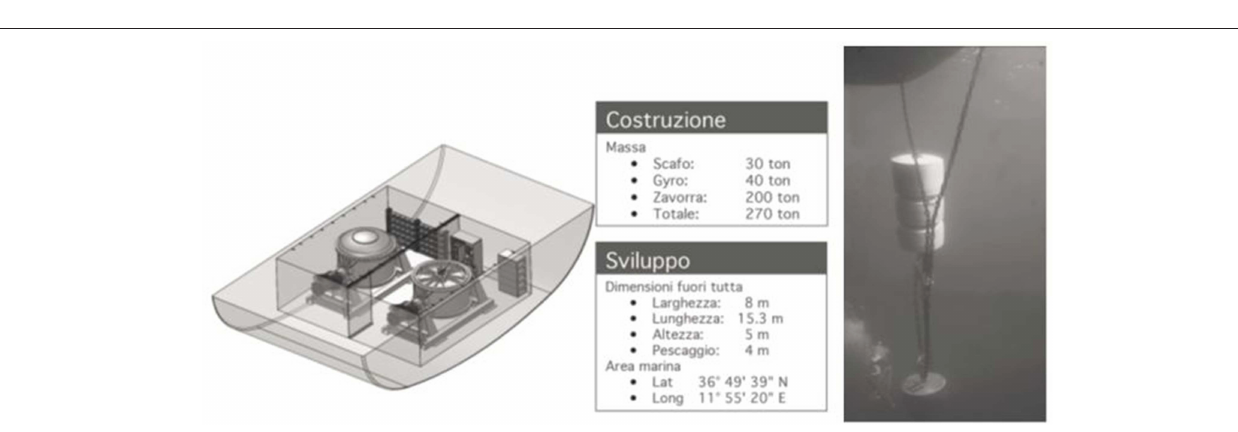
FIGURE 13 | ISWEC hull and principal components. Dimensions and features of the device (Left) and picture of mooring (Right)